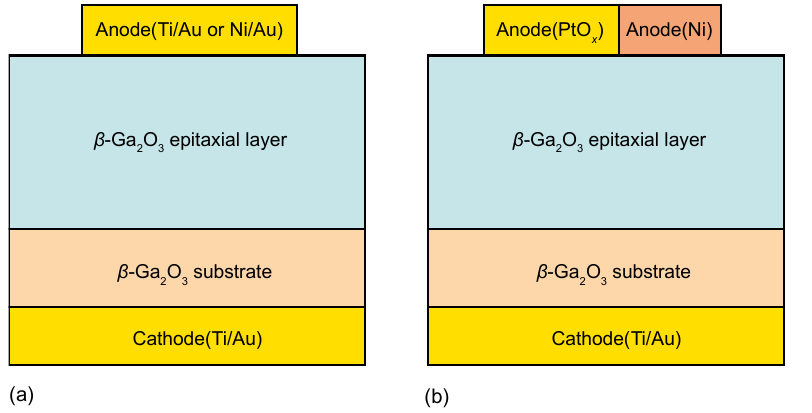
Figure 2. ( a ) Device diagram of the β -Ga 2 O 3 SBD with different anode metals. ( b ) Device diagram of the double ‐ barrier β‐ Ga 2 O 3 .